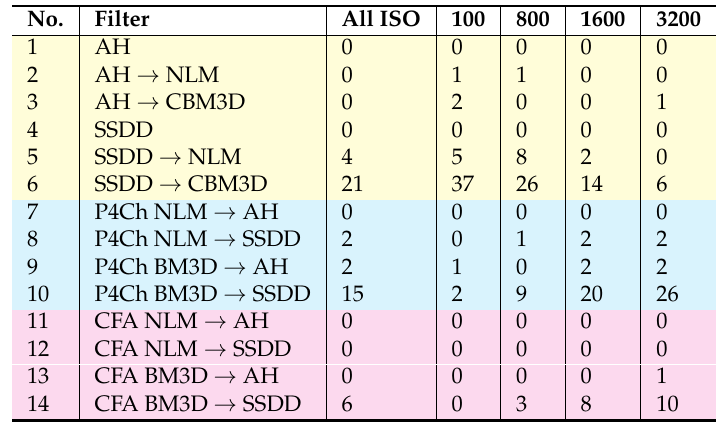
Table 4. Number of “wins” for individual filtering schemes according to the achieved value of PSNR